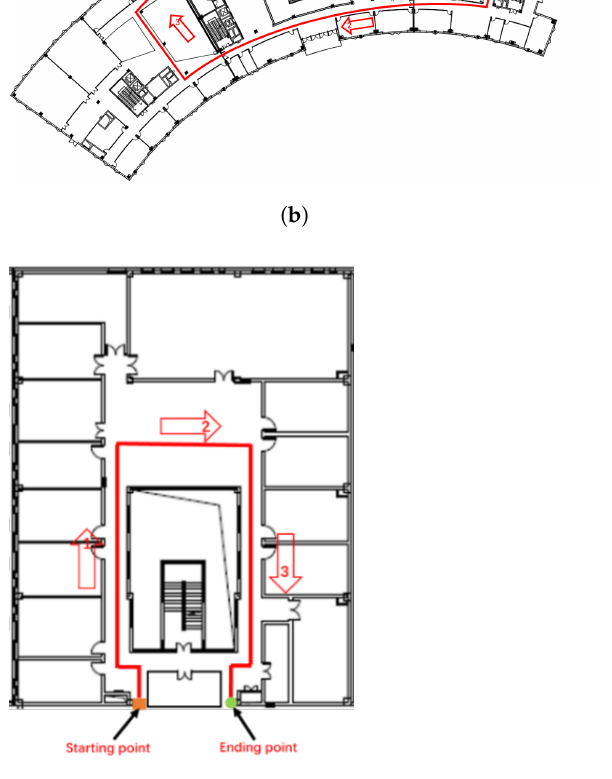
Figure 8. Layout of data collection locations for scenarios 1 ( a ), 2 ( b ), and 3 ( c